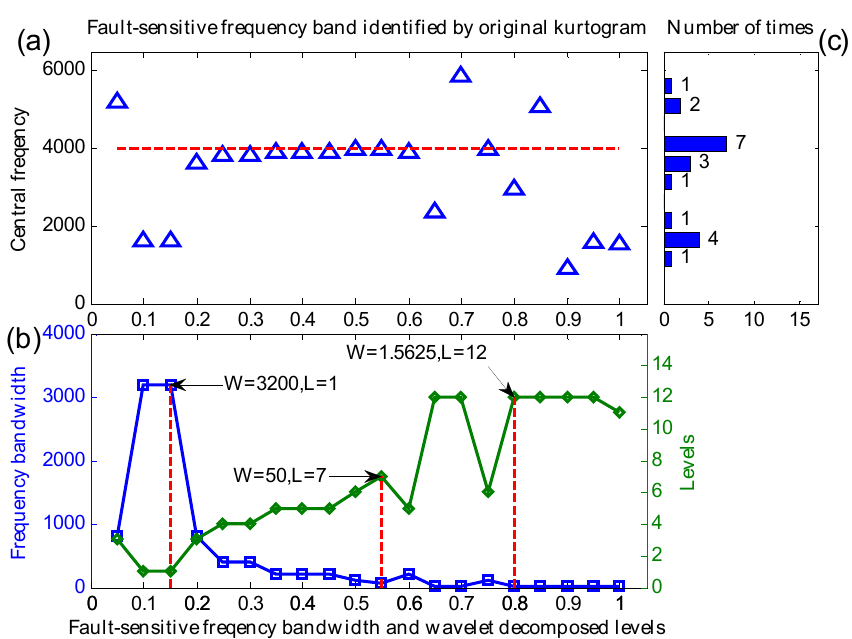
Figure 10. ( a ) The central frequencies; ( b ) the frequency bandwidth and decomposition levels; ( c ) distribution of central frequencies.